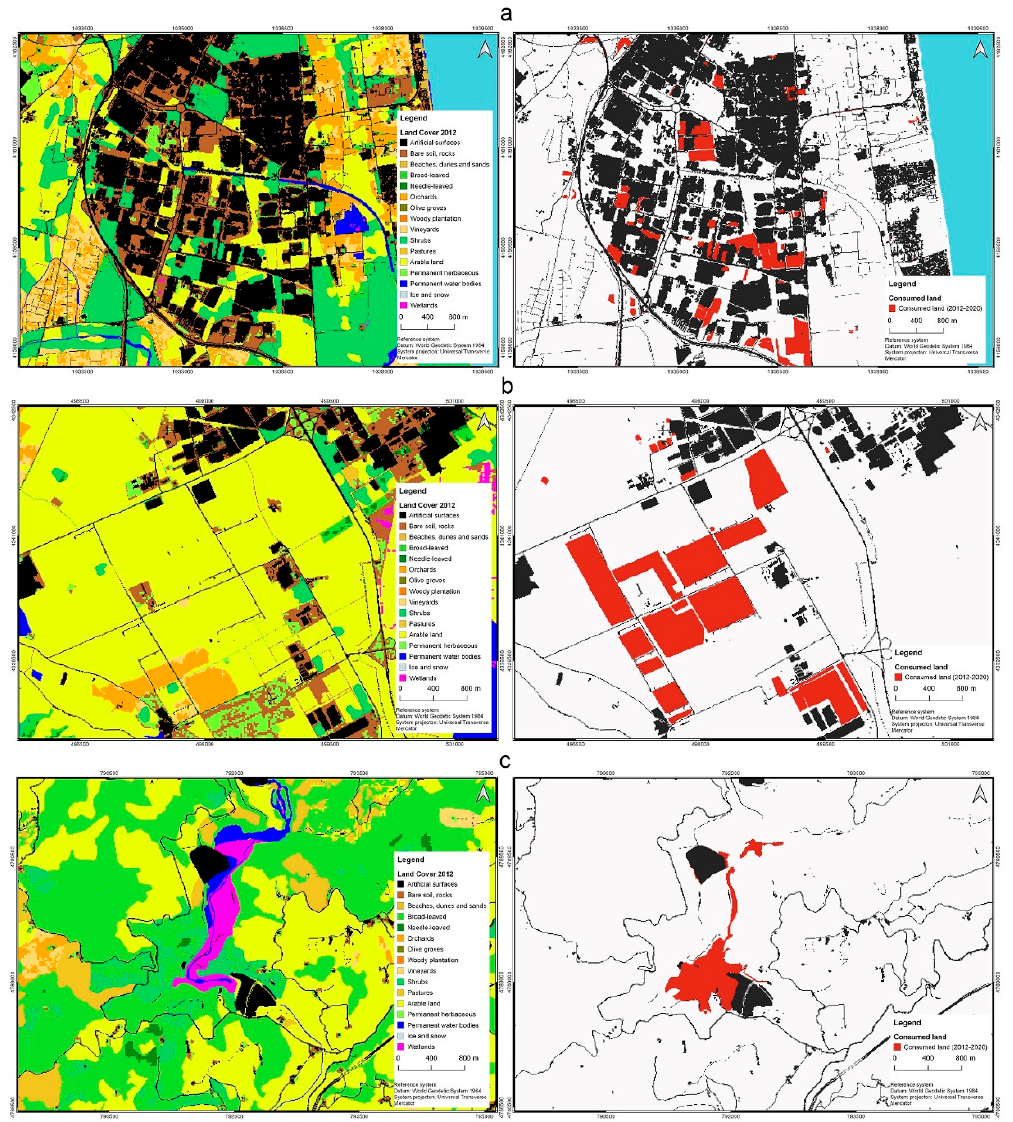
Figure 3. Examples of land consumption in urban ( a ), agricultural ( b ), and natural ( c ) environments.